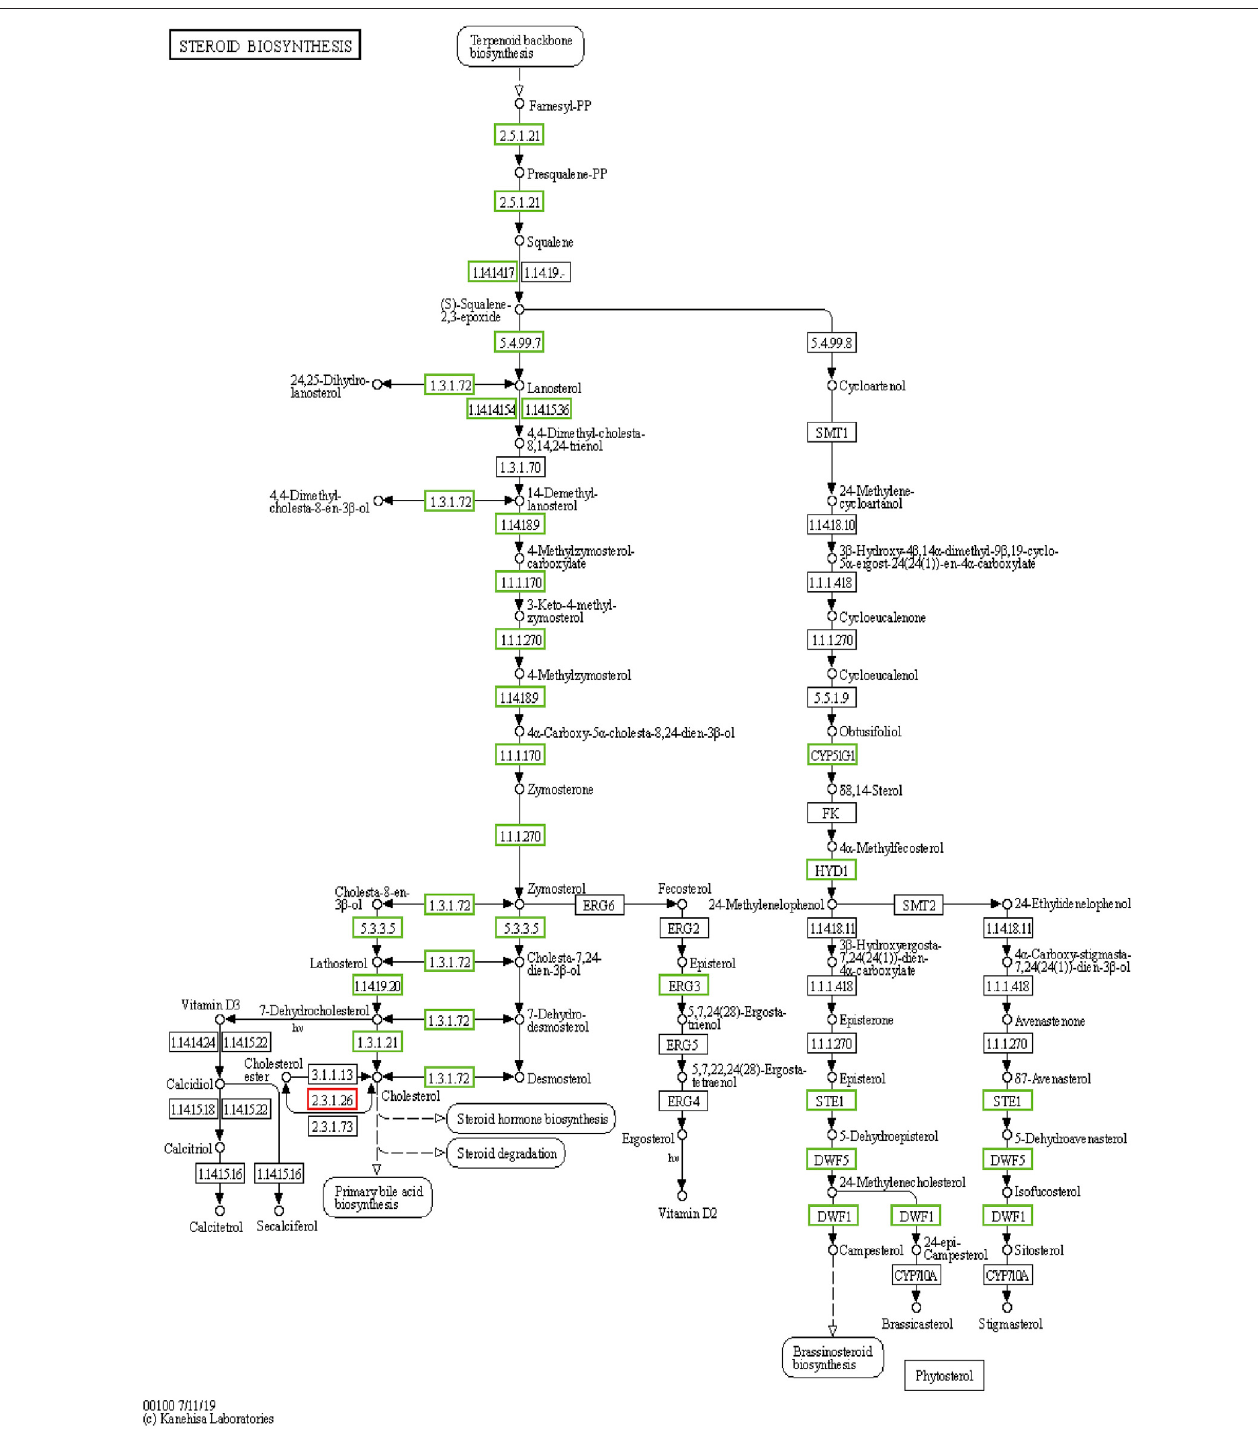
FIGURE 8 | Multiple genes in the F0-VS-F16 steroid biosynthesis pathway were signi fi cantly downregulated during IM.